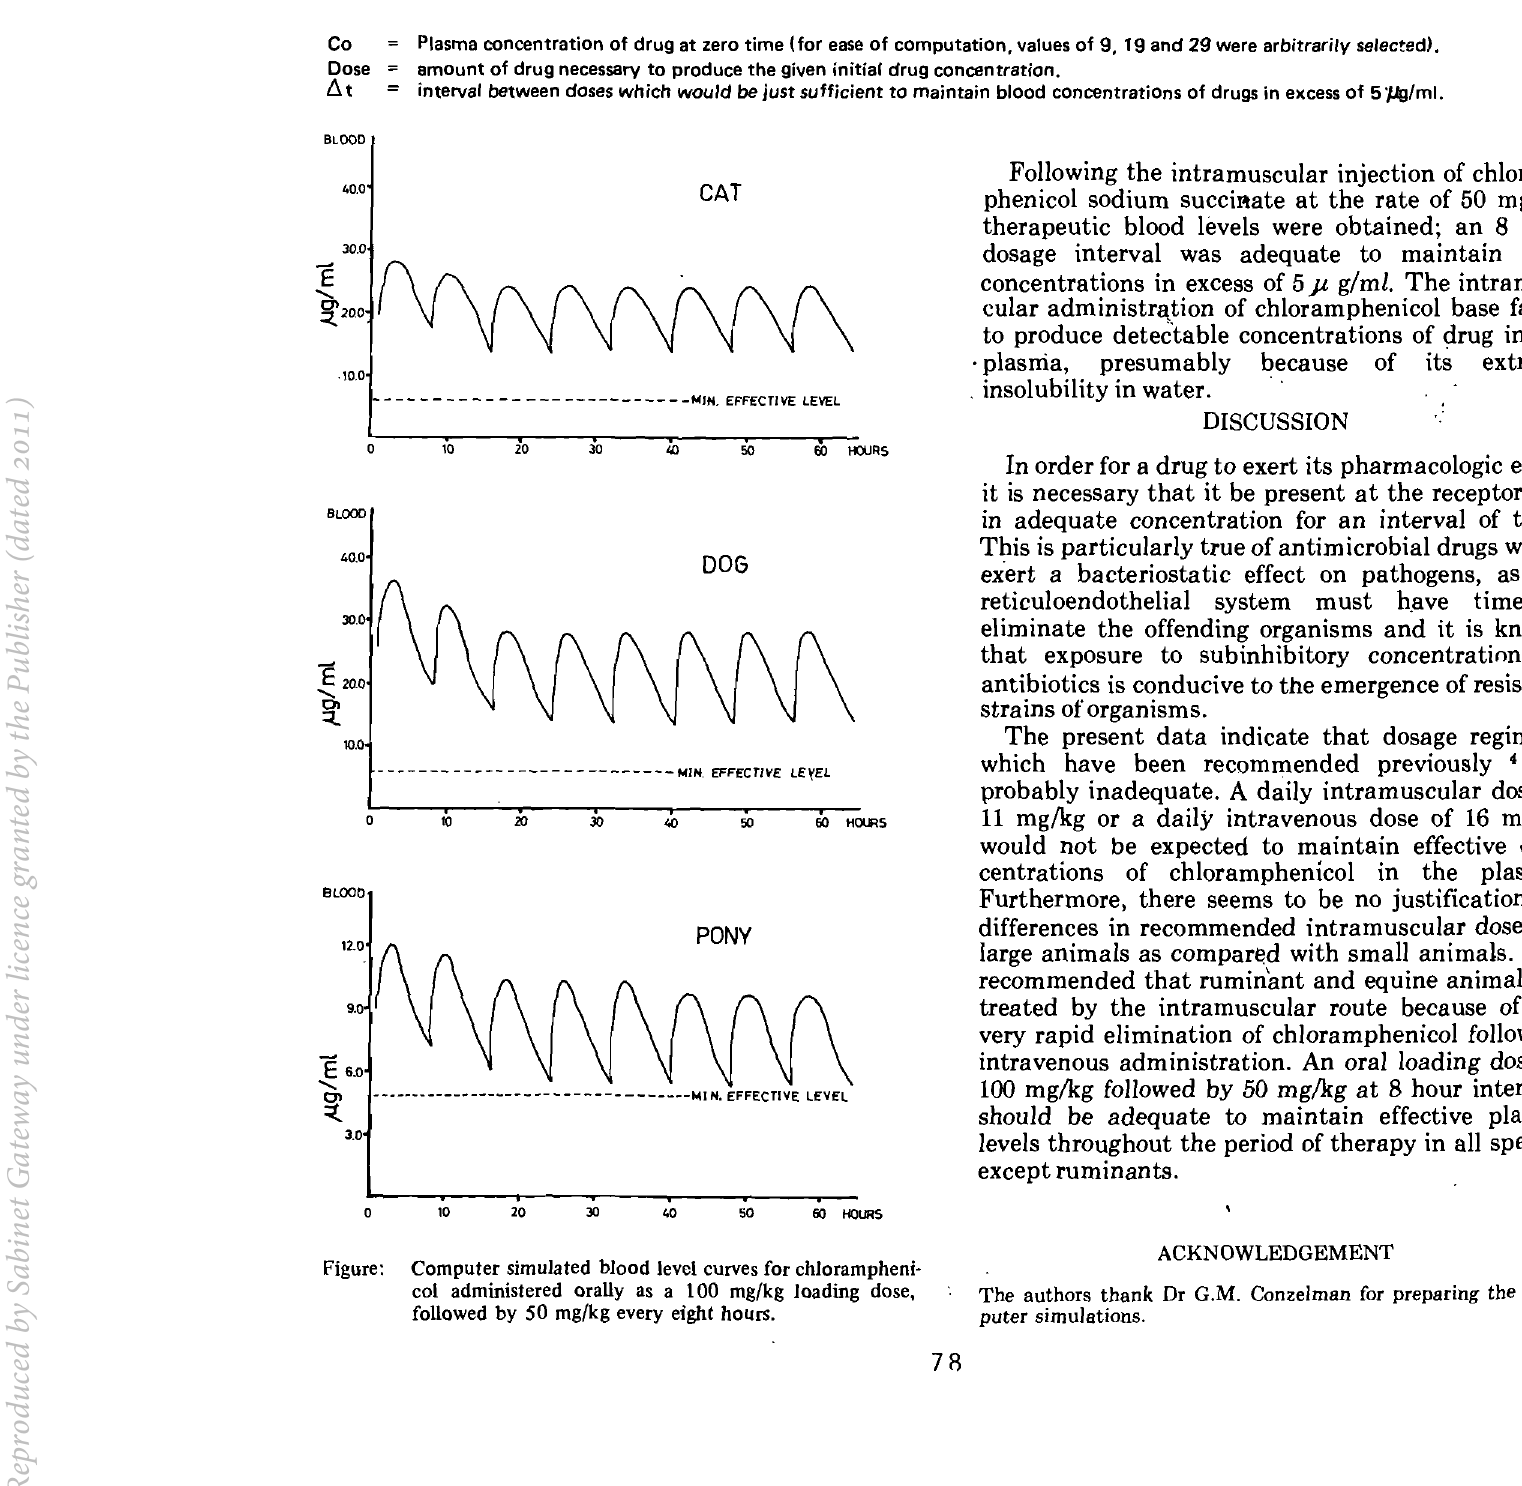
Figure: Computer simulated blood level curves for chlorampheni col administered orally as a 100 mgfkg loading dose, followed by 50 mgfkg every eight